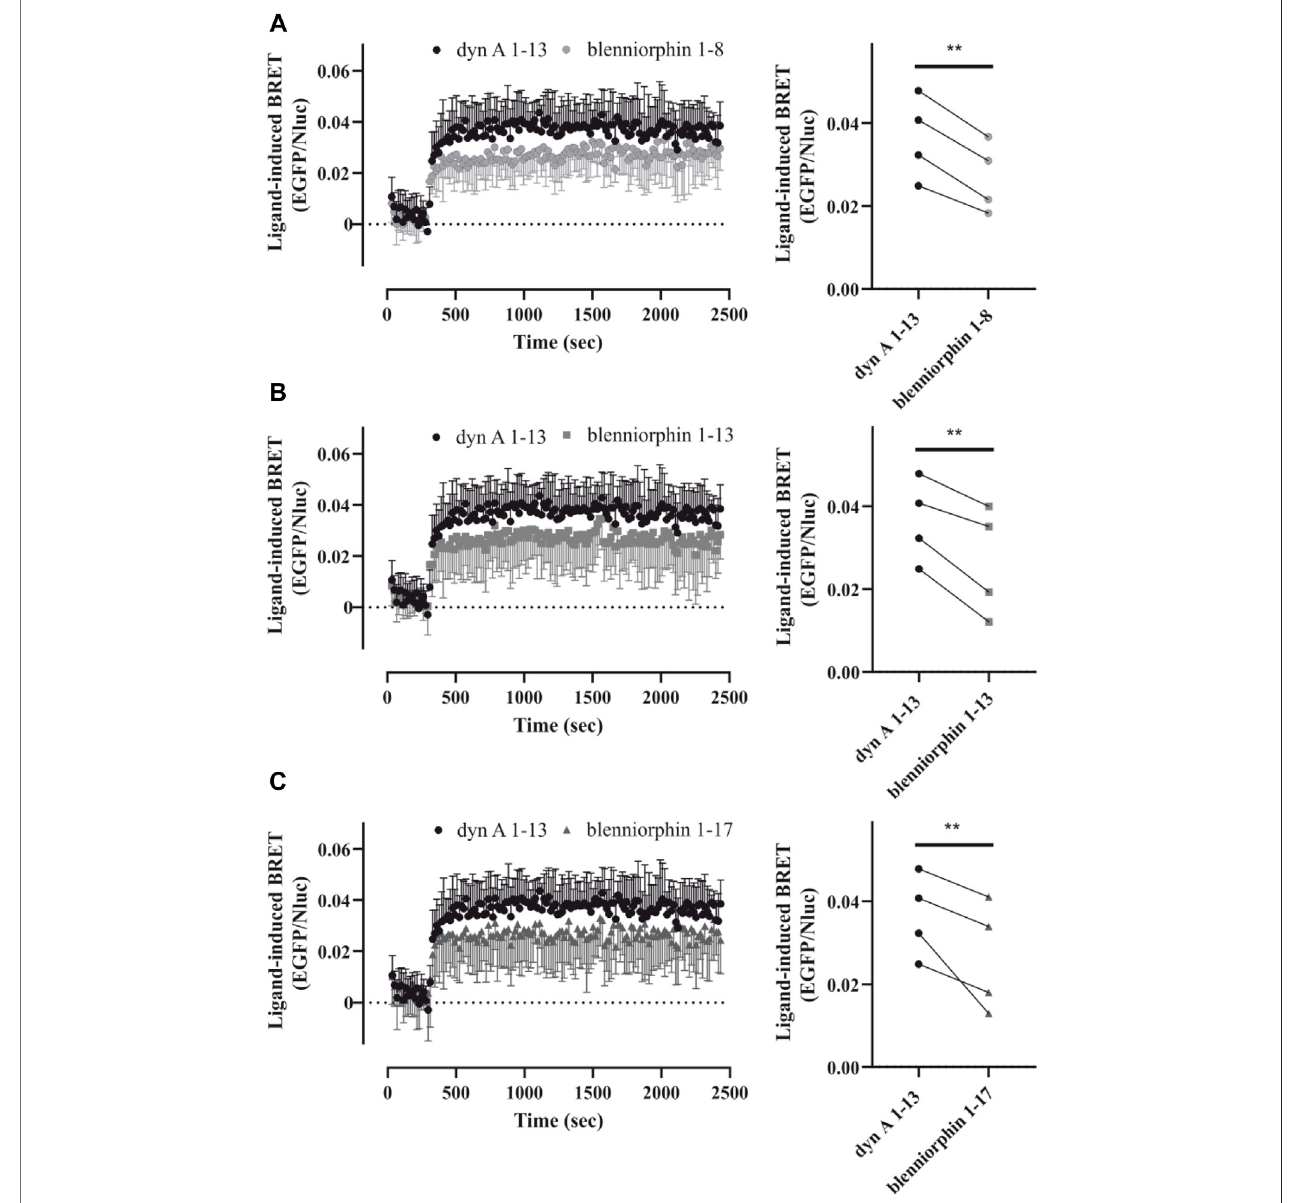
FIGURE 4 | β -arrestin-2 recruitment by the KOR after stimulation by blenniorphins. (A – C) Recruitment of β -arrestin-2-Nluc by the EGFP-tagged KOR was measured over time by bioluminescence resonance energy transfer (BRET) prior to and after activation of the receptor by 10 µM blenniorphins 1 – 8 (A) , 1 – 13 (B) and 1 – 17 (C) (graphs on the left). In each instance, the HEK293 cells transiently co-expressing mouse KOR-EGFP and β -arrestin-2-Nluc were also stimulated with 10 µM dynorphin (dyn)A1 – 13that wasused astheinternal control. Dataareshown asmean ± SD( n (cid:2) 4).Foreach BRET dataset,ligand-induced arrestin recruitment by blenniorphins was quanti fi ed relative to the effect elicited by 10 µM dynorphin (dyn) A 1 – 13 and are shown as spaghetti plots (graphs on the right). Dyn A 1 – 13 controls arethesame for (A – C) .Statisticalsigni fi cancewascalculatedbyrepeated measuresANOVA, followedbyaDunnetpost-hoccomparison ( **p < 0.01 ).EGFP,enhanced green fl uorescence protein; Nluc,